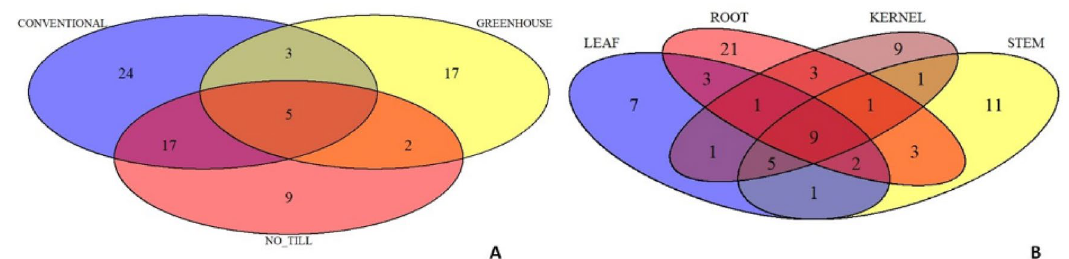
Figure 8. Relationship of fungal community composition between the studied ( a ) management strategies and ( b ) wheat